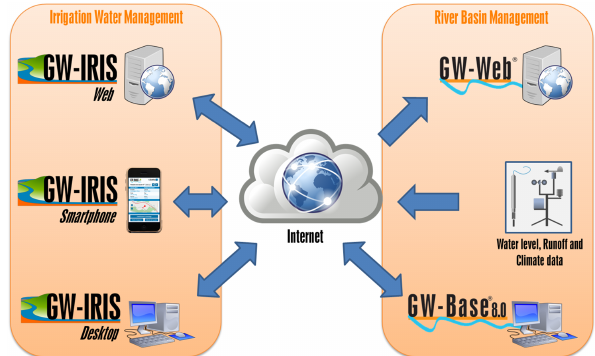
Figure 4. The complete software system. Communication scheme of the water monitoring and management system GW-Base and the newly developed irrigation administration system